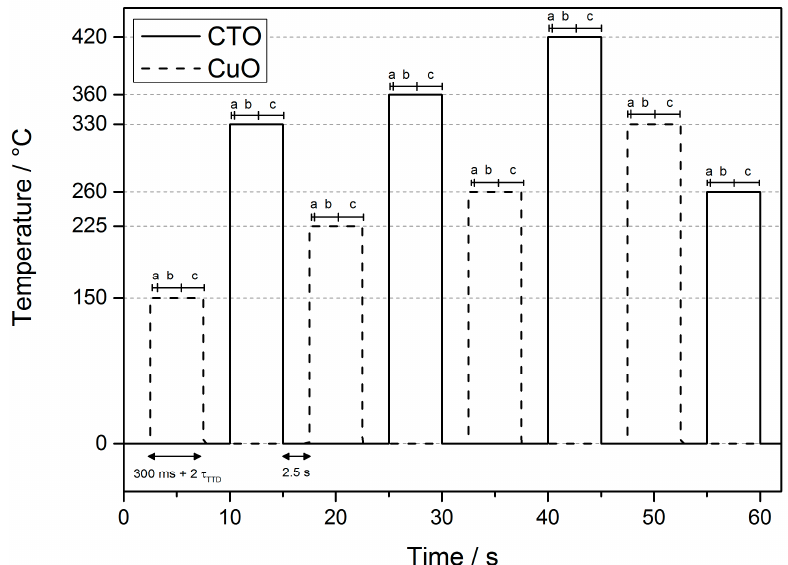
Figure 4. Temperature protocol used in normal operational mode. Each temperature step comprises 300 ms preheating time (a), and two (b, c) time to digital measurement phases of both sensor resistive layers. A 2.5 s time gap between every step is used for wireless data transmission. Please note that the times b and c depend on the layer’s resistivity values and consequently vary considerably. As a consequence, the total duration time of the measurement cycle is not constant.